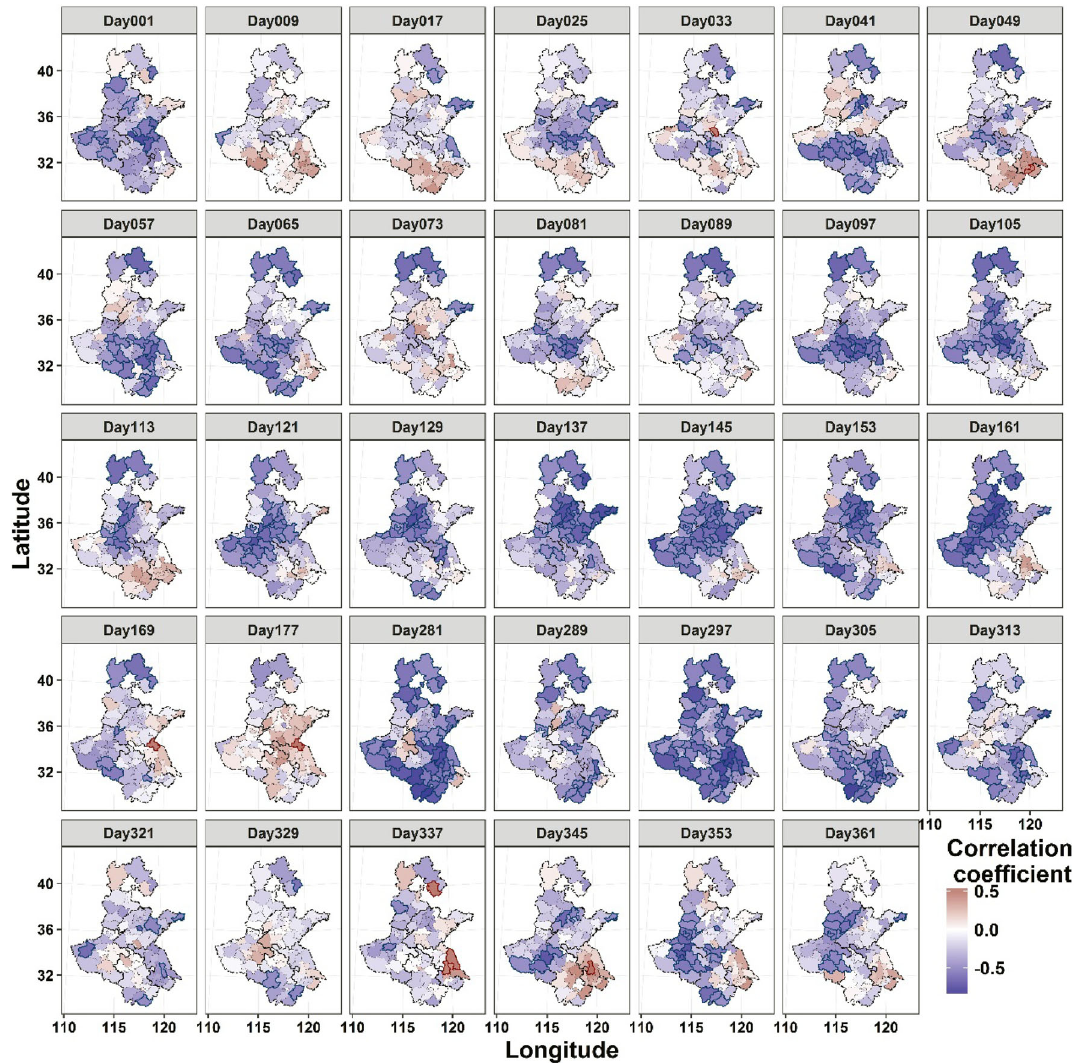
Fig. 8 Spatial pattern of correlations between moderate drought-affected crop area and winter wheat yield in Anhui, Hebei, Henan, Jiangsu, and Shandong Provinces, China,